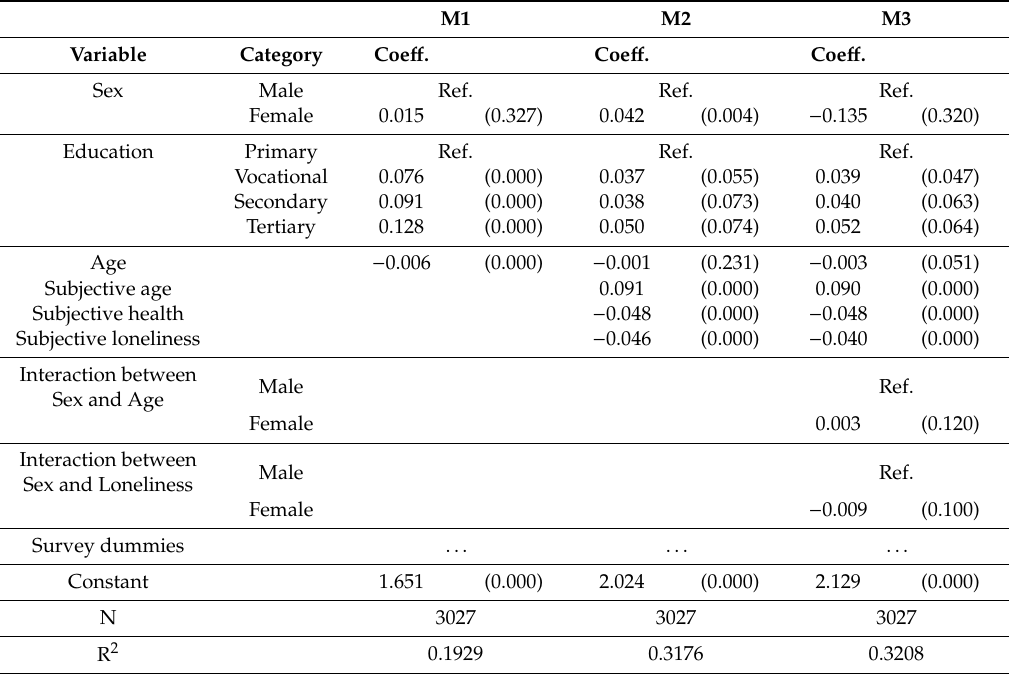
Table 3. Determinants of the POLA scale (OLS regression, significance in